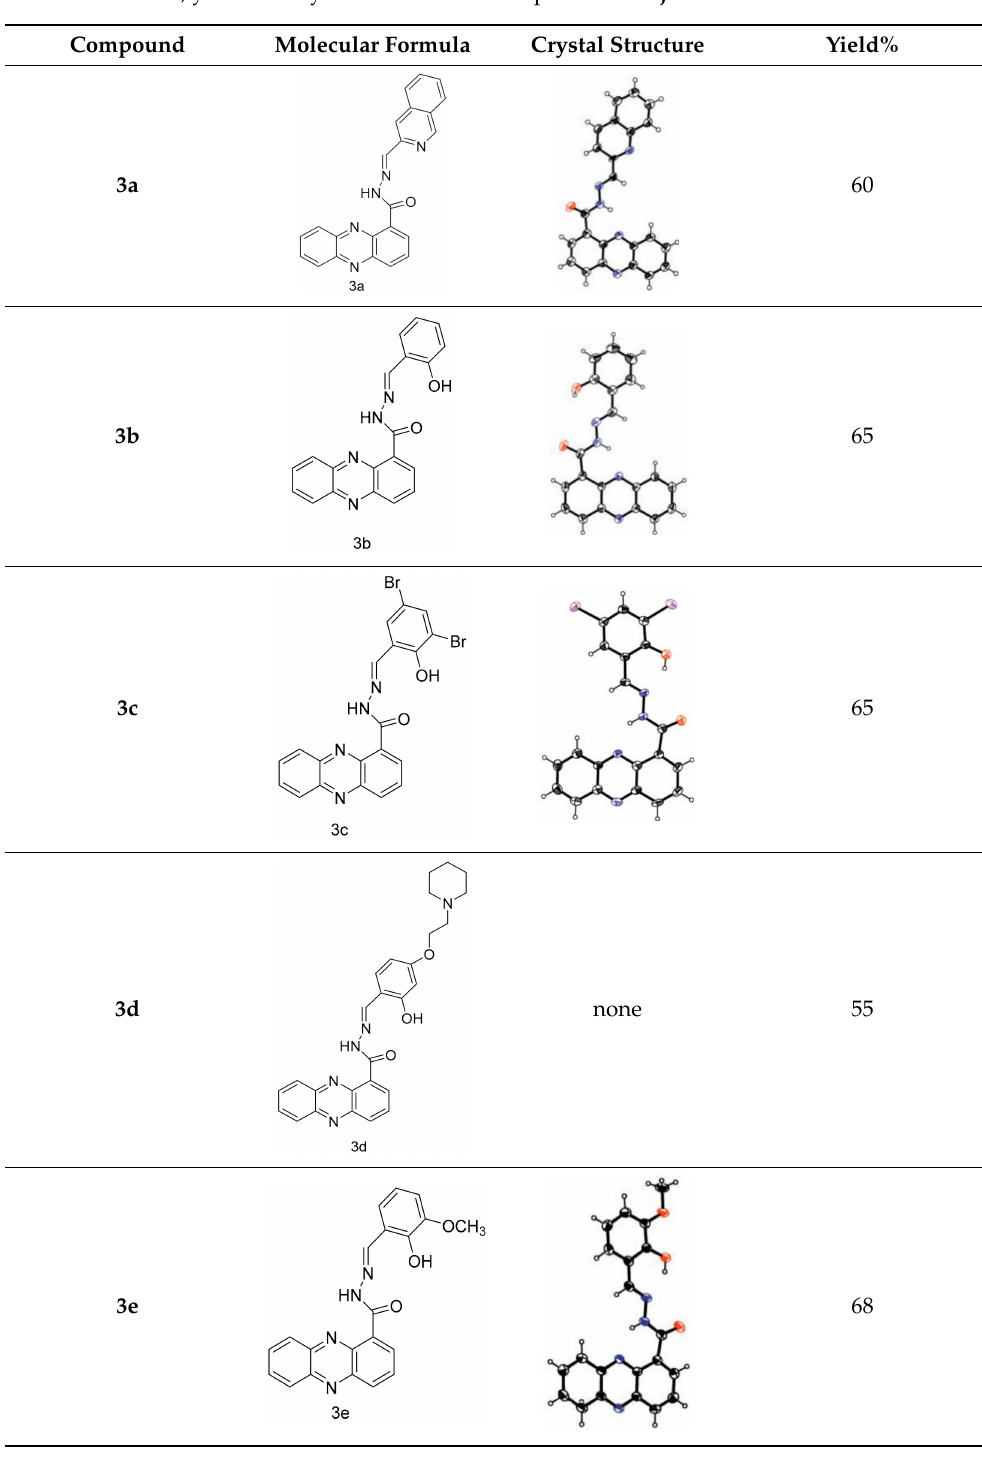
Table 1. Structure, yield and crystal structures of compounds 3a – 3j